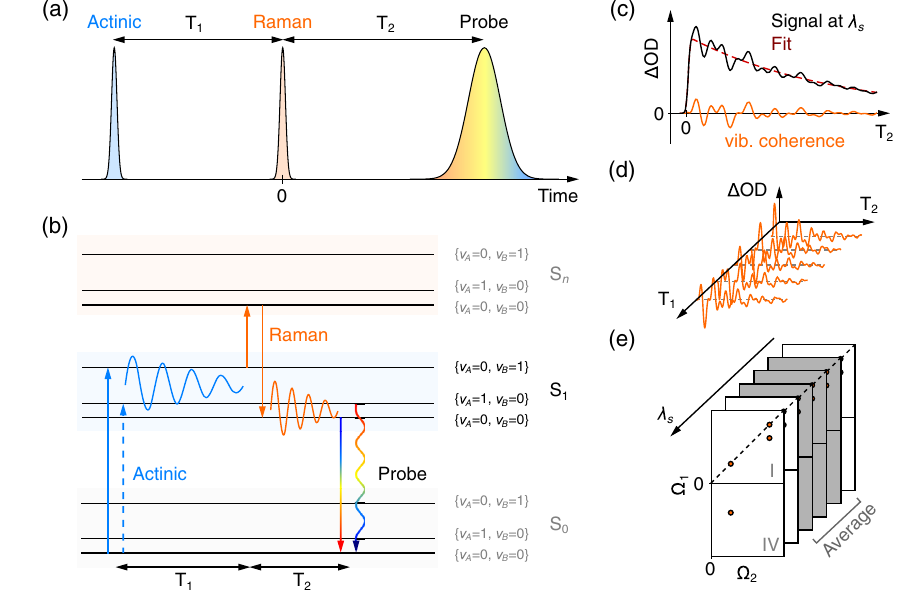
FIG. 1. Concept of 2D-ISRS. (a) Pulse sequence used for the experiment. (b) Energy ladder scheme illustrating an example of signal generation. Horizontal black lines represent the vibrational levels of the sample organized in three electronic manifolds. Dotted and solid arrows indicate light interactions with the ket and the bra side of the density matrix representing the state of the system. (c) – (e) Overview of the data analysis required in 2D-ISRS. (c) Transient absorption signals recorded along T 2 for a given T 1 over all probe wavelengths λ and the vibrational coherence contribution, which is isolated by fitting and subtracting the electronic background. (d) At each λ collect the coherence for each T 1 to build S ð T 1 ; T 2 Þ , which is (e) subsequently 2D Fourier transformed to yield S ð Ω 1 ; Ω 2 Þ , after averaging the WLC probe wavelengths λ along the desired resonance s